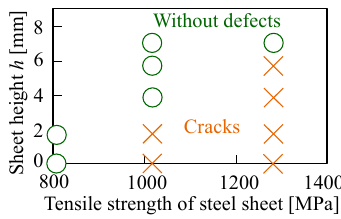
Figure 11. Joining range by hemming.